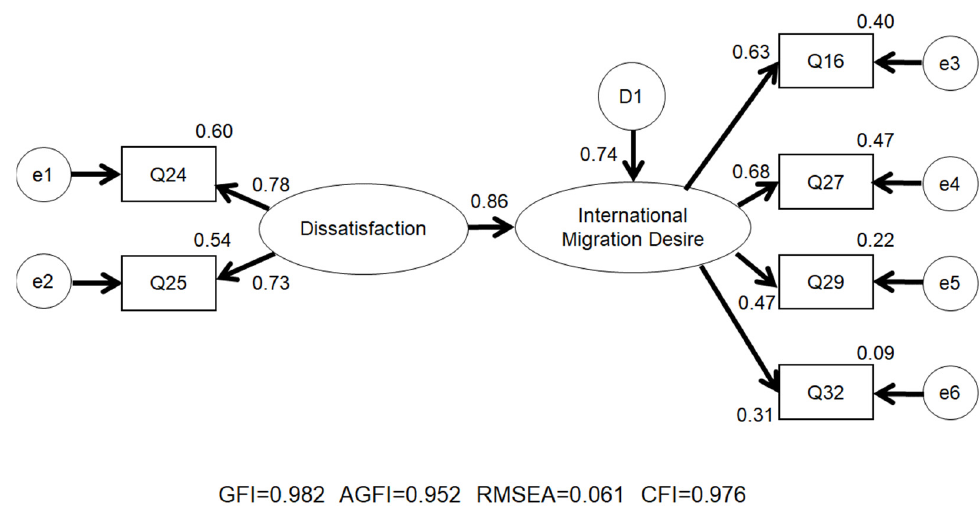
Figure 1. Path diagram as a result of the SEM.